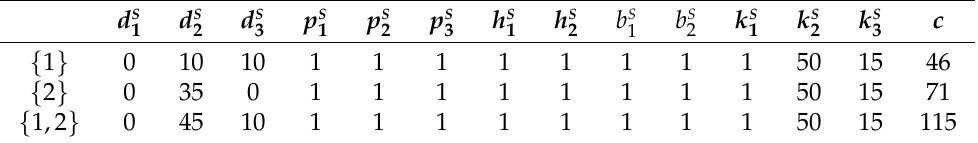
Table 7. SI-situation with three periods and two players with the associated SI-game.